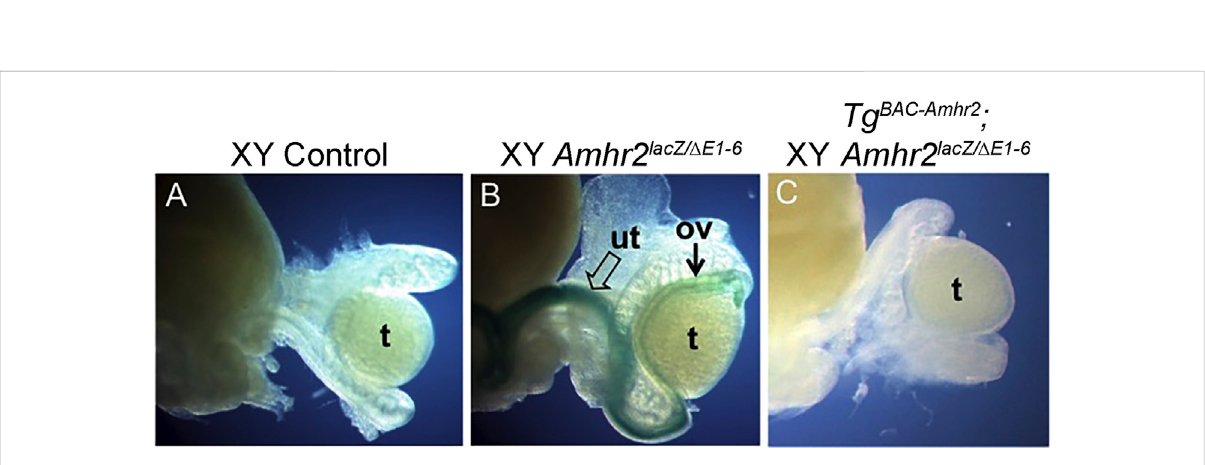
FIGURE 2 An Amhr2 -containing BAC transgene rescues the block in Müllerian duct regression of Amhr2 -null male mice. (A) Control male mouse possesses only male reproductive tract organs (epididymis, vas deferens) seen adjacent to the testis. (B) Amhr2 Δ E1-6/lacZ (null) male mouse carry one deletionalleleandone lacZ knock-in/knockoutallele. lacZ expressionmarkstheuterus(openarrow)andoviduct(arrow)thatformsinthesemutants. (C) Male mouse with the Amhr2 BAC transgene ( Tg BAC-Amhr2 ) on an Amhr2 Δ E1-6/lacZ background lacks lacZ expression because the block in Müllerian duct regression has been rescued preventing uterus/oviduct differentiation (Line 1, n = 2; Line 2, n = 2). Ov, oviduct; t, testis; ut,